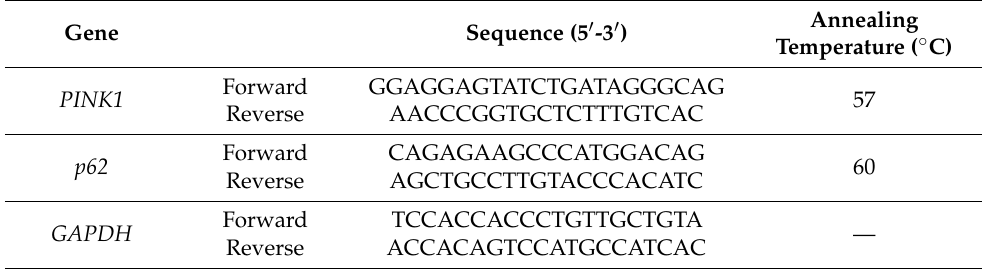
Table 2. Primer sequences with respective annealing temperatures for genes assessed.